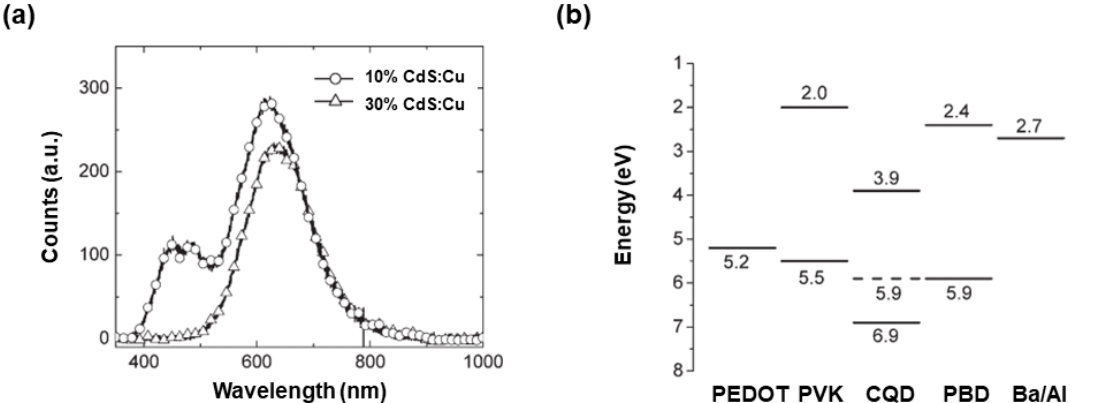
Figure 3. ( a ) Electroluminescence (EL) spectra of LEDs with 10% and 30% w / w Cu-doped CdS CQDs in the matrix of PVK / PBD. ( b ) Band diagram of LEDs. The dash line represented the Cu energy level. Reproduced from reference [227].